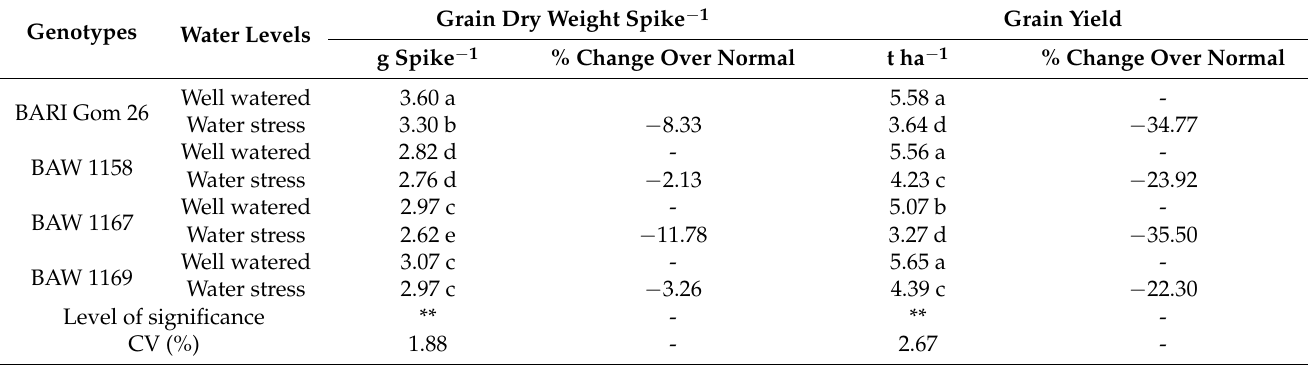
Table 10. Effect of DS on the grain dry weight spike − 1 and grain yield of different wheat genotypes.